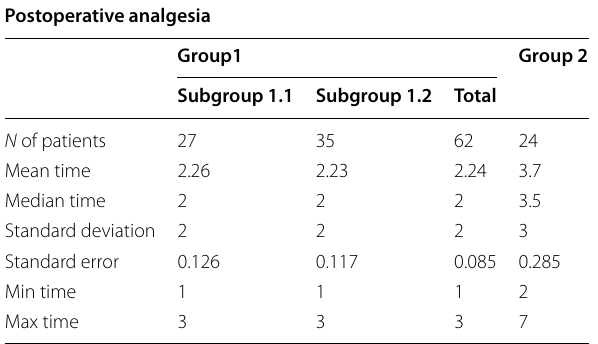
Table 5 Analysis of postoperative analgesia between group 1 and group 2